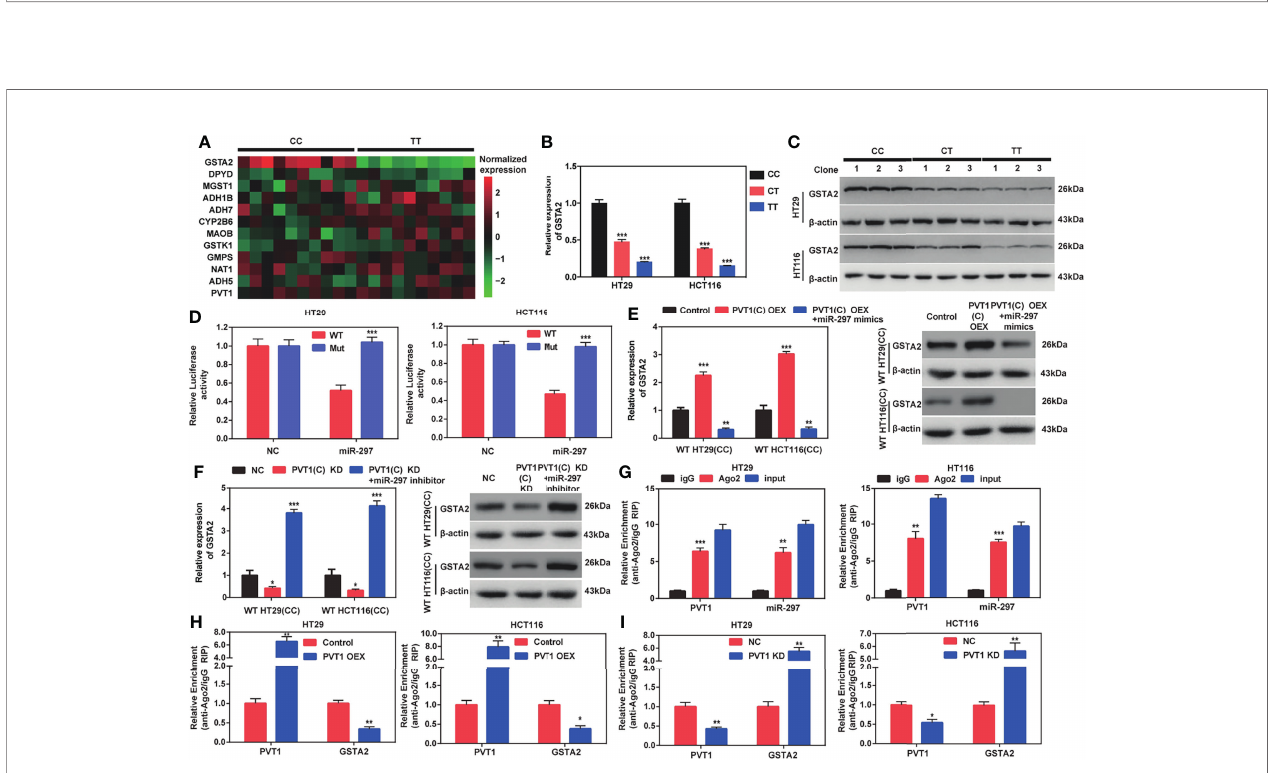
FIGURE 5 | PVT1 carrying with rs2278176 C allele regulates GSTA2 in an Ago2-dependent manner through binding hsa-miR-297. (A) Heat map of the expression levels of PVT1 and 11 genes involved in the drug metabolism pathway in tumor tissues of CRC patients harboring CC and TT genotypes. The low and high expression levels are denoted by green and red colors, respectively ( n = 10 for each genotype). (B, C) GSTA2 mRNA and protein levels in HT29 and HCT116 cells carrying different rs2278176 genotypes ( n = 3 independent clones in each genotype, *** P < 0.001, compared with CC genotype, one-way ANOVA; error bars: SEM). (D) Relative reporter gene activity of psi-CHECK-2 containing mutant or wild-type GSTA2 3 ′ -UTR co-transfected with miRNA control or hsa-miR-297 mimics in wild type HT29 and HCT116 cell lines ( n = 3 each, *** P < 0.001, compared with the psi-CHECK-2 containing wild-type GSTA2 3 ′ -UTR, two-sided t -tests; error bars: SEM). (E, F) Relative expression of GSTA2 mRNA and protein in wild type HT29 and HCT116 cell lines co-transfected with PVT1(C allele) overexpression plasmid and hsa-miR-297 mimics (E) or PVT1 siRNA and hsa-miR-297 inhibitor (F) ( n = 3 each, *** P < 0.001, compared with the cells transfected with empty vector or negative control siRNA, one-way ANOVA; error bars: SEM). (G) Relative enrichment of PVT1 and hsa-miR-297 on Ago2 in wild type HT29 and HCT116 cell lines ( n = 3 each, ** P < 0.01, *** P < 0.001, compared with IgG, two-sided t -tests; error bars: SEM). (H, I) Relative enrichment of PVT1 and GSTA2 on Ago2 in wild type HT29 and HCT116 cell lines transfected with PVT1(C allele) overexpression plasmid (H) or PVT1 siRNA (I) ( n = 3 each, * P < 0.05, ** P < 0.01, compared with the cells transfected with empty vector or negative control siRNA, two-sided t- tests; error bars: